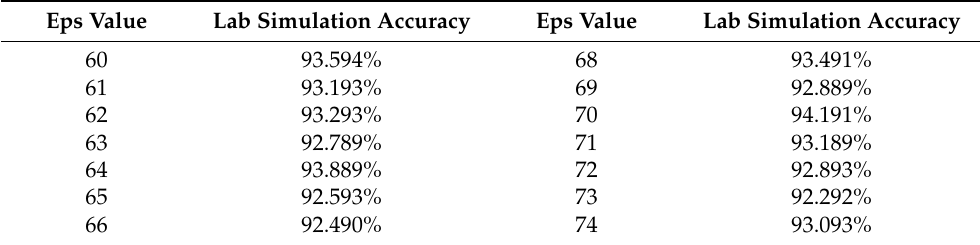
Table 3. Simulation accuracies for different eps values (training epochs number = 1000, MinPts = 4).